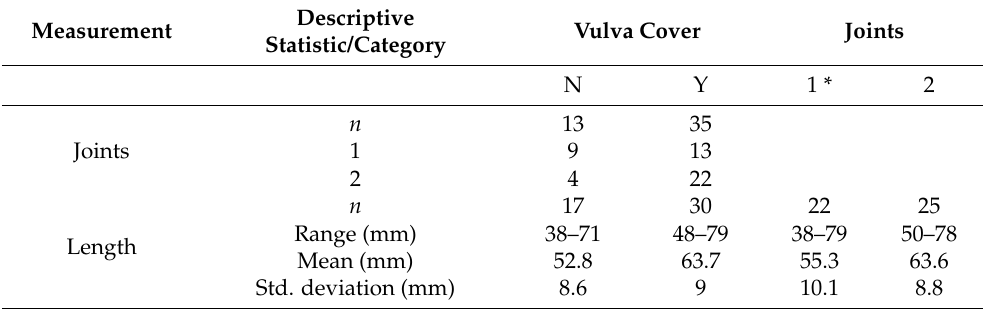
Table 5. Descriptive statistics of the measurement methods used to assess weaner tails.